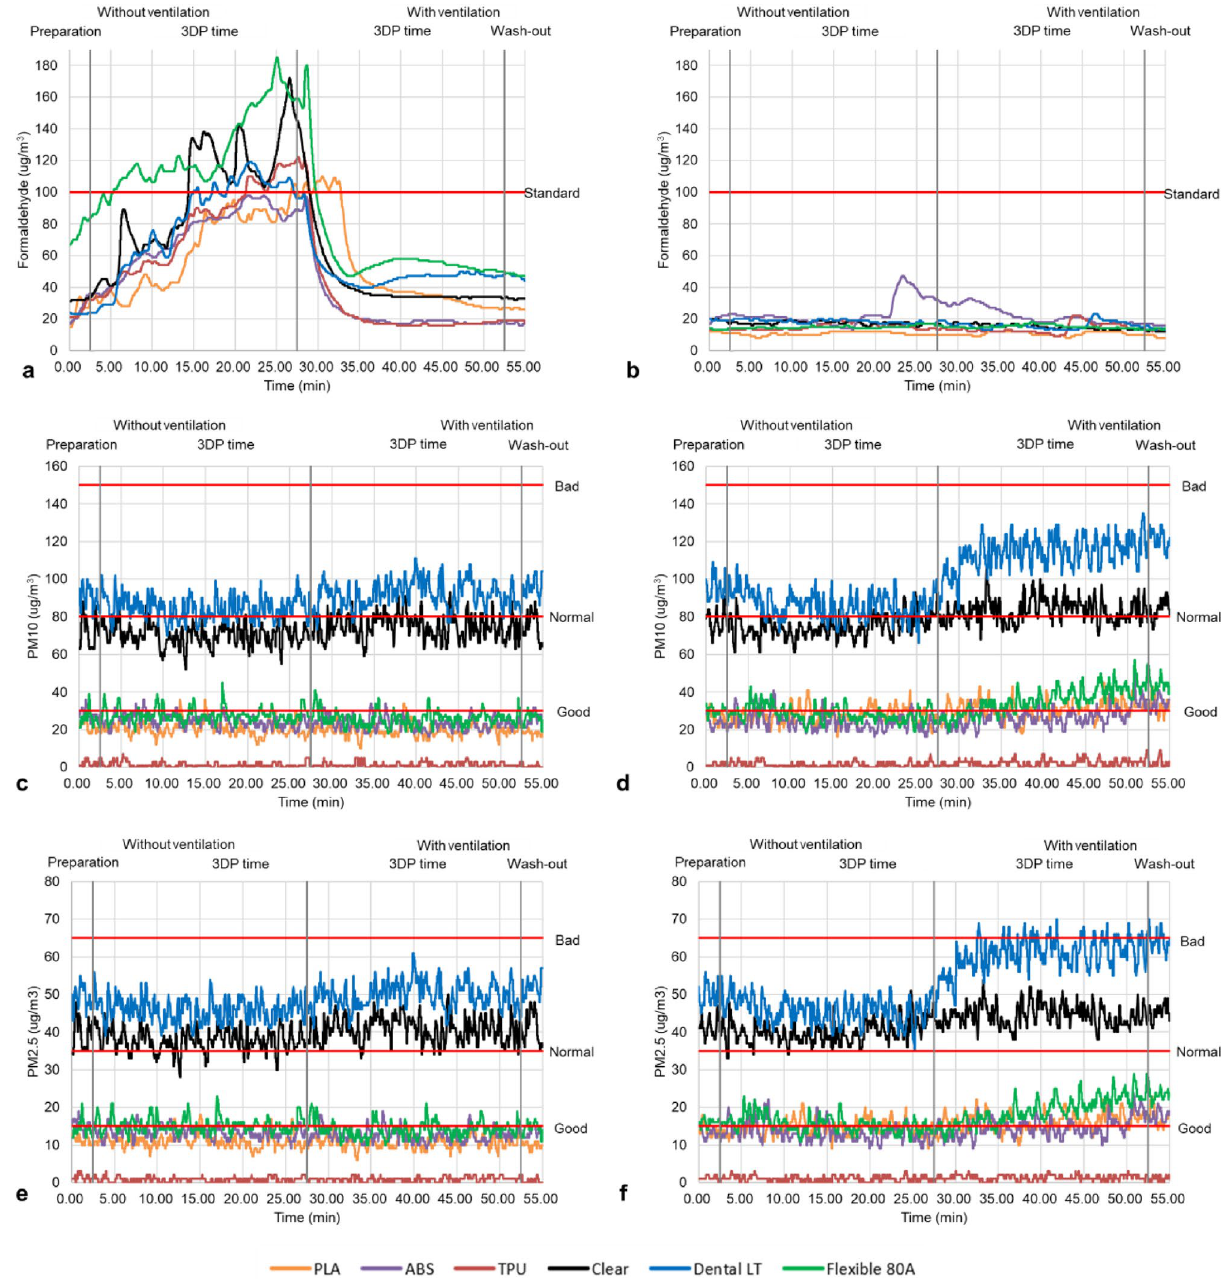
Figure 5. Retest of emission amount for the polylactic acid (PLA), acrylonitrile butadiene styrene (ABS), and thermoplastic polyurethane (TPU) with materials extrusion (ME) and Clear, Dental LT, and Flexible 80A with the vat photopolymerization (VP) divided by 4 stages in the ( a ) 3D printing (3DP) workspace and ( b ) the control setting of formaldehyde, ( c ) the 3DP workspace and d. the control setting of particulate matters 10 (PM 10 ), and ( e ) the 3DP workspace and f. the control setting of particulate matters 2.5 (PM 2.5 more severe in formaldehyde than in PM 10 and PM 2.5 (Figs. 4 and 5). Nevertheless, statistically significant differ- ences were demonstrated in all experiments (P < 0.001 or P < 0.01) (Supplementary Table S3). Comparison of hazardous materials emission based on ventilation in the 3DP workspace. The hazardous materials that change depending on whether the ventilation is working (stages I and II) or not (stages III and IV) were compared in the 3DP workspace (Table 3). The formaldehyde area differences ranged from 283.22 to 1343.04 µg × min/m 3 in the test and 490.43–1598.27 µg × min/m 3 in the retest, whereas the PM 10 and PM 2.5 had relatively small differences ranging from − 66.16 to 46.87 µg × min/m 3 in the test and − 195.09 to 87.84 µg × min/m 3 in the retest. Figures 4 and 5a,c,e depict the change in hazardous materials emitted as ventila- tion switches off to on a test–retest.